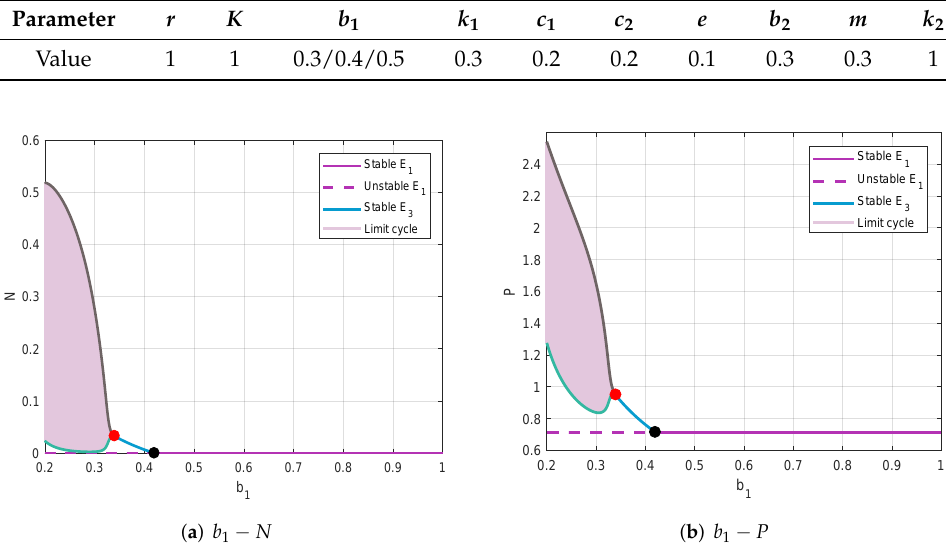
Table 1. Values of parameter to see the impacts of predation rate.